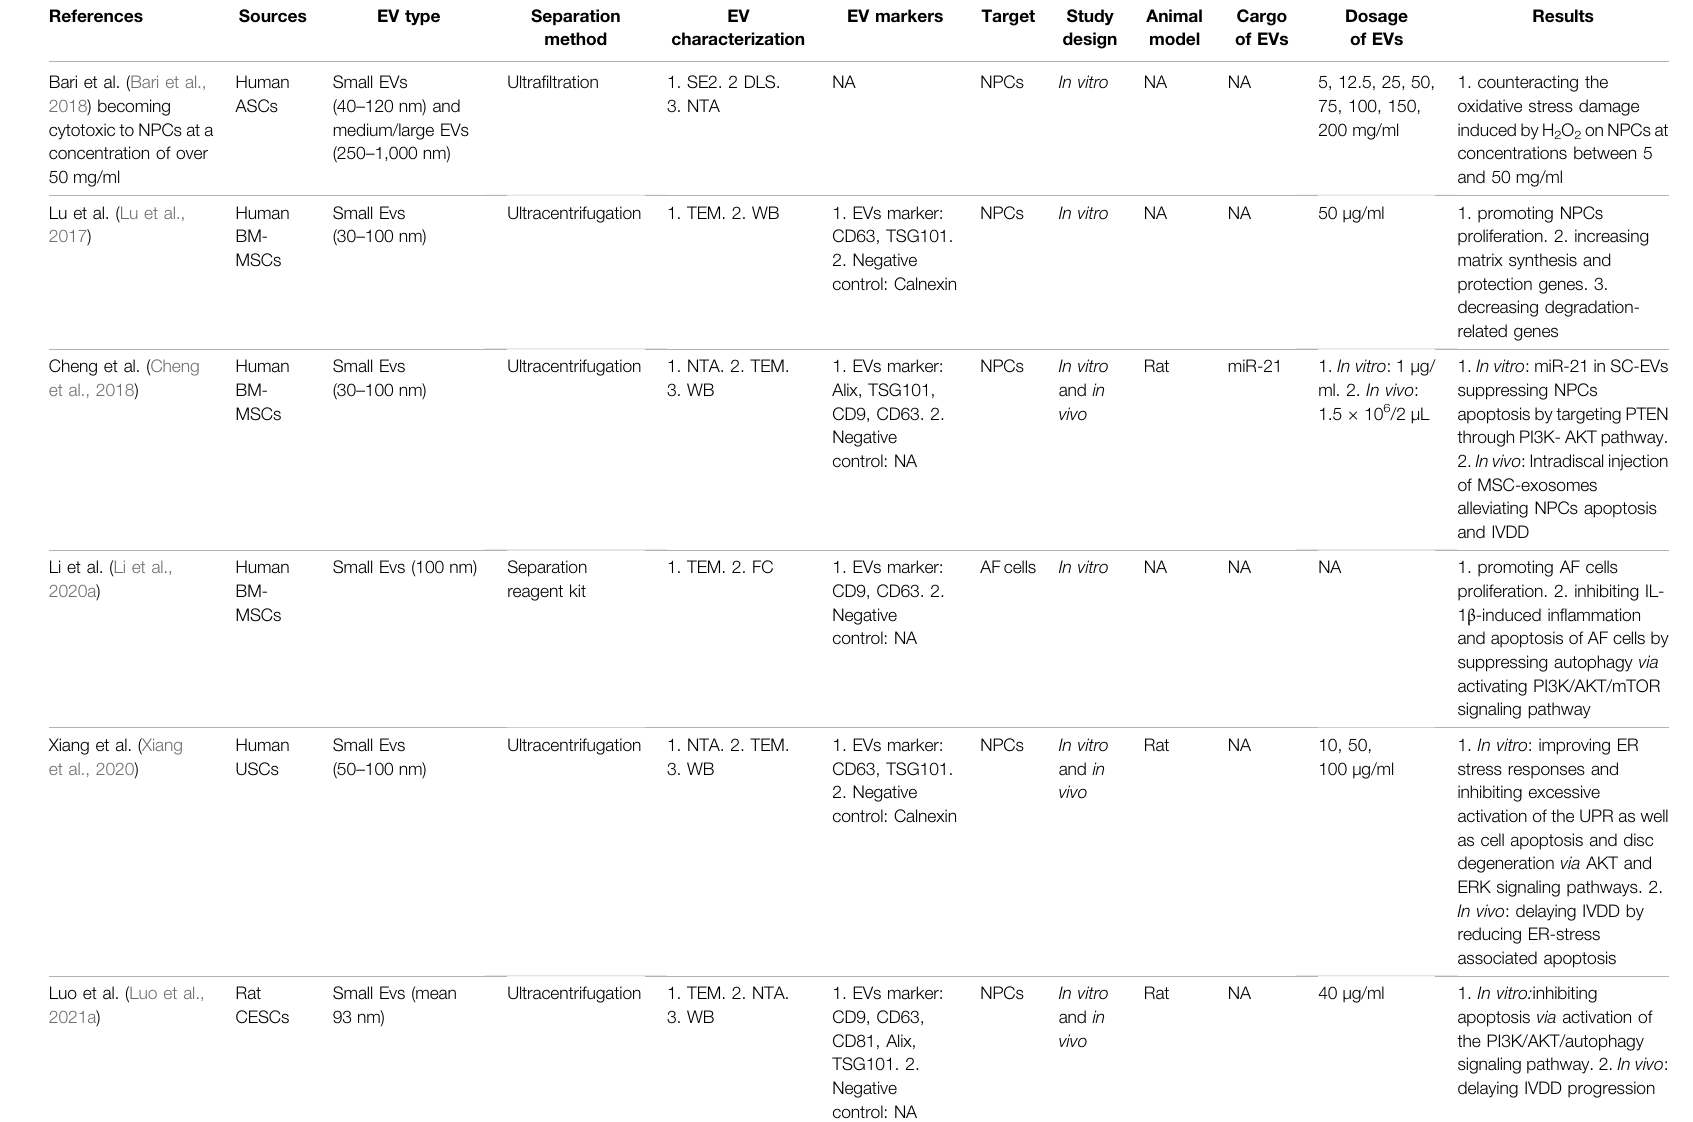
TABLE 1 | Details of stem cell-derived extracellular vesicles for intervertebral disc